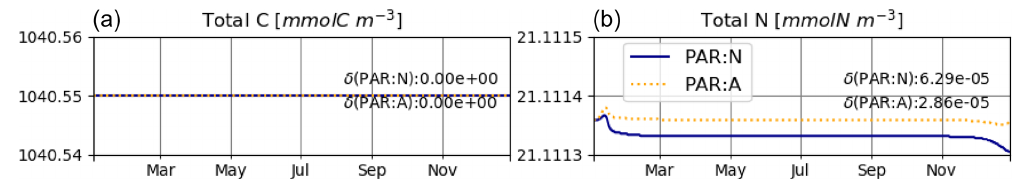
Figure 2. T1: carbon (a) and nitrogen (b) pools for the PAR:N (solid blue line) and PAR:A (dashed orange line) simulations.